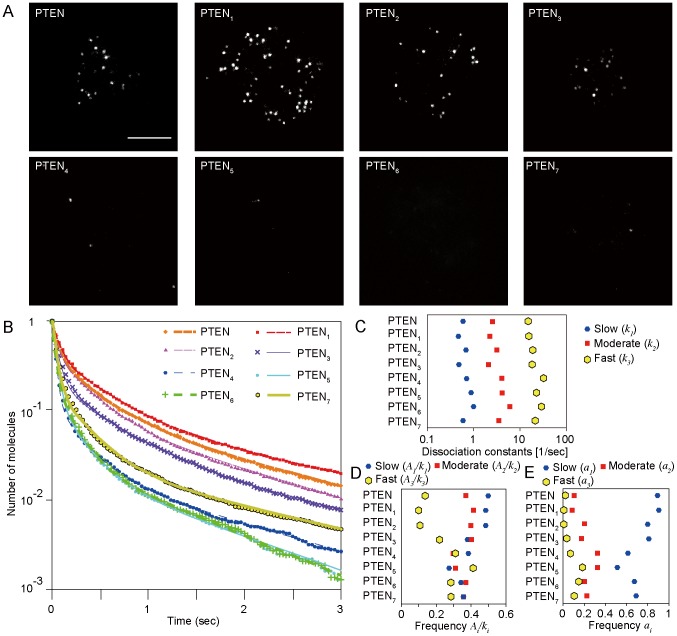
Single-molecule imaging of wild-type PTEN and PTENi mutants.(A) Images of cells expressing wild-type PTEN or PTENi mutants labeled with TMR captured under TIRFM. Scale bar, 5 µm. (B) The numbers of PTEN-Halo-TMR and PTENi-Halo-TMR molecules that remained bound to the membrane are plotted against time after membrane association. Lines are three-component exponential fits (Eq. 1). The cumulative plots were obtained from 16,088 molecules in 8 cells (wild-type PTEN), 12,164 molecules in 8 cells (PTEN1), 9,022 molecules in 7 cells (PTEN2), 11,386 molecules in 8 cells (PTEN3), 12,406 molecules in 8 cells (PTEN4), 11,079 molecules in 8 cells (PTEN5), 10,822 molecules in 7 cells (PTEN6) and 20,683 molecules in 8 cells (PTEN7). (C, D) Dissociation constants k
1–3 (C) and frequencies A
1–3/k
1–3 (D) of PTENi mutants obtained from the fitting in (B). Estimated parameters are shown in Table 2. (E) Frequency of slow, moderate and fast diffusion mobility states, ai, from the displacement distribution analysis in Fig. S3.